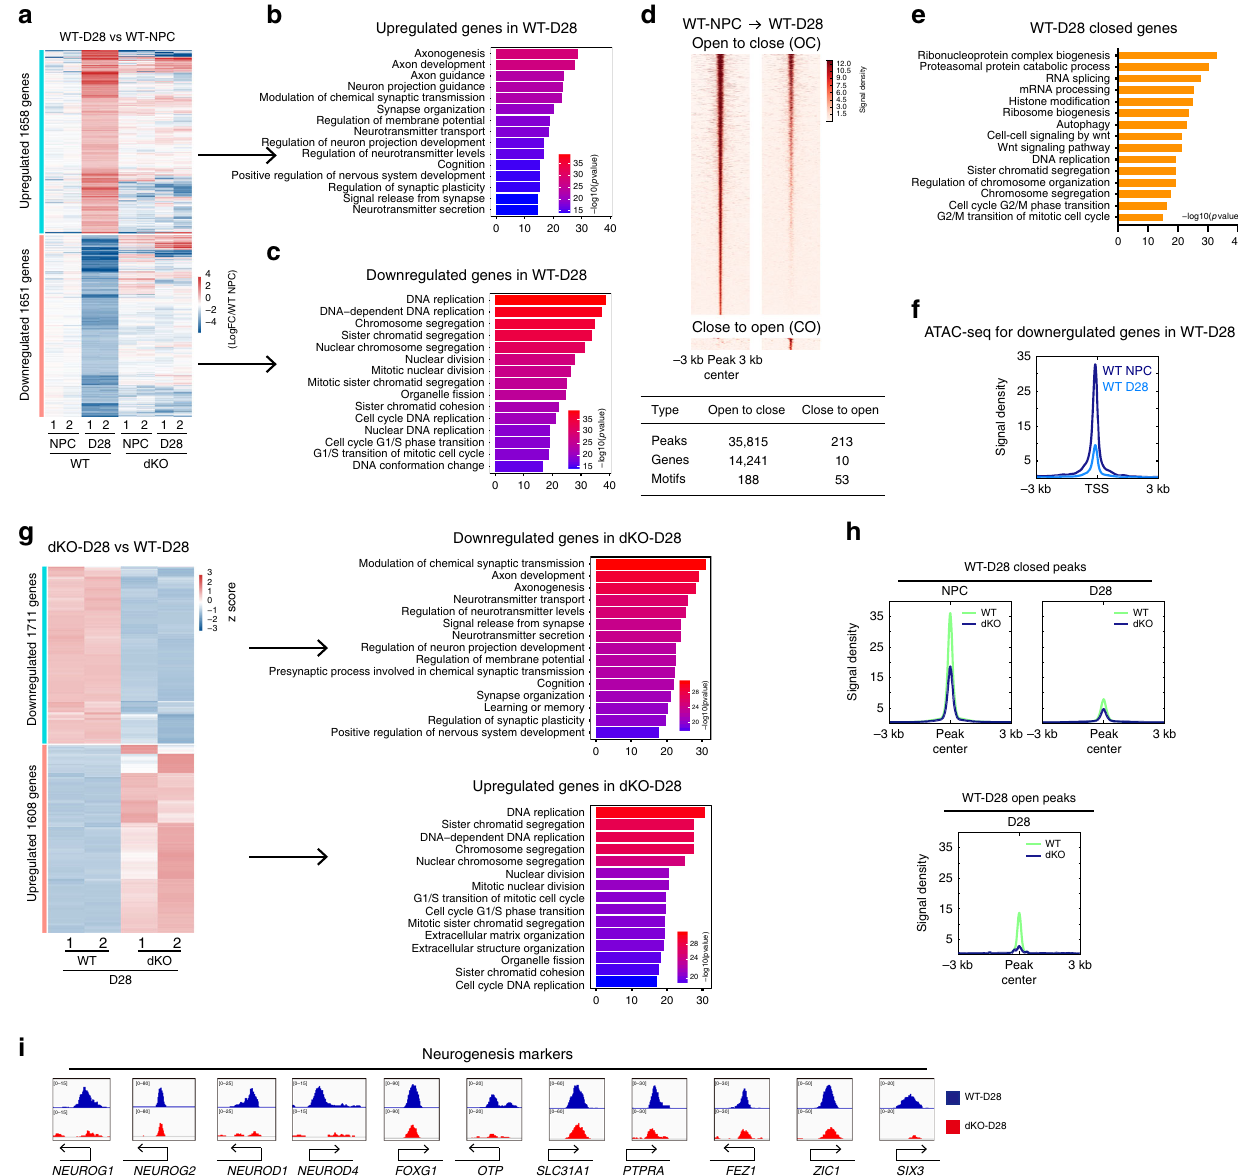
Fig. 5 KDM6s are essential in the epigenetic switch from NPCs to neural subtypes. a Heatmap of upregulated or downregulated genes in wild-type (WT)-D28 compared with wild-type (WT) NPCs. Expression levels are shown as fold changes (log2) compared with expression levels in WT NPCs. b , c Top 15 GO terms most enriched in up- or downregulated genes in differentiated WT-D28 cells. d Left panel, heatmap of ATAC-seq data indicating regions with differential chromatin accessibility between WT NPCs and differentiated cells at D28. Right panel, numbers of OC or CO regions. OC, open-to-closed, indicates regions with reduced chromatin accessibility in differentiated cells at D28. CO, closed-to-open, indicates regions with increased chromatin accessibility in differentiated cells at D28. e GO analysis for OC region-associated genes described in d . f ATAC-seq analysis indicating genes downregulated in differentiated WT-D28 cells compared with WT NPCs. g Heatmap and GO analysis of differentially expressed genes between WT and dKO cells at day 28 of differentiation. dKO, deletion of both JMJD3 and UTX. h Signal densities from ATAC-seq data for the indicated regions described in d . i Genomic views of genes involved in neuronal development indicated by ATAC-seq data from differentiated WT-D28 or dKO-D28 cells. WT wild